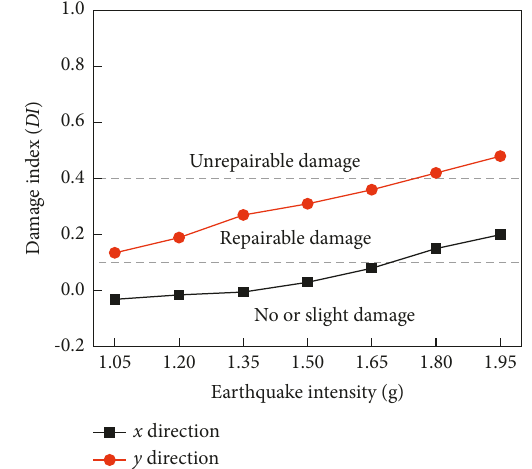
Figure 16: Variation of specimen damage indices with earthquake